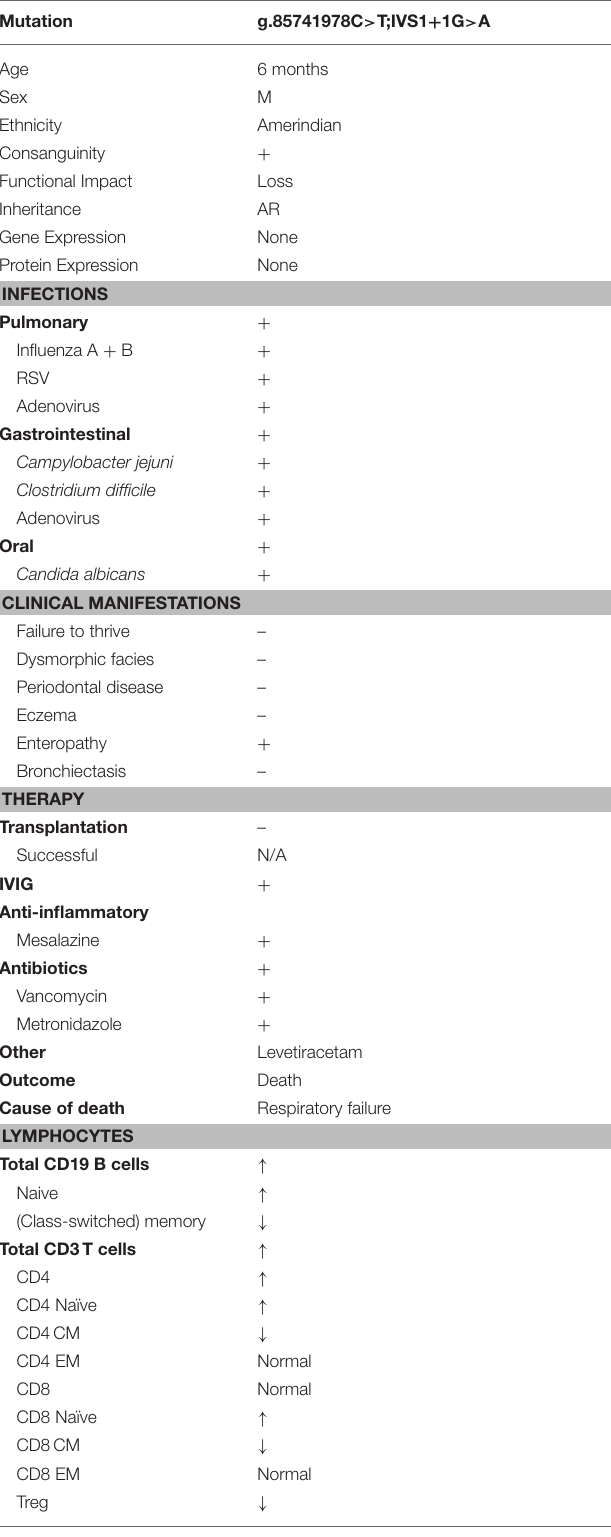
TABLE 6 | Clinical and laboratory phenotype of human BCL10 deficiency (LOF BCL10 mutations).